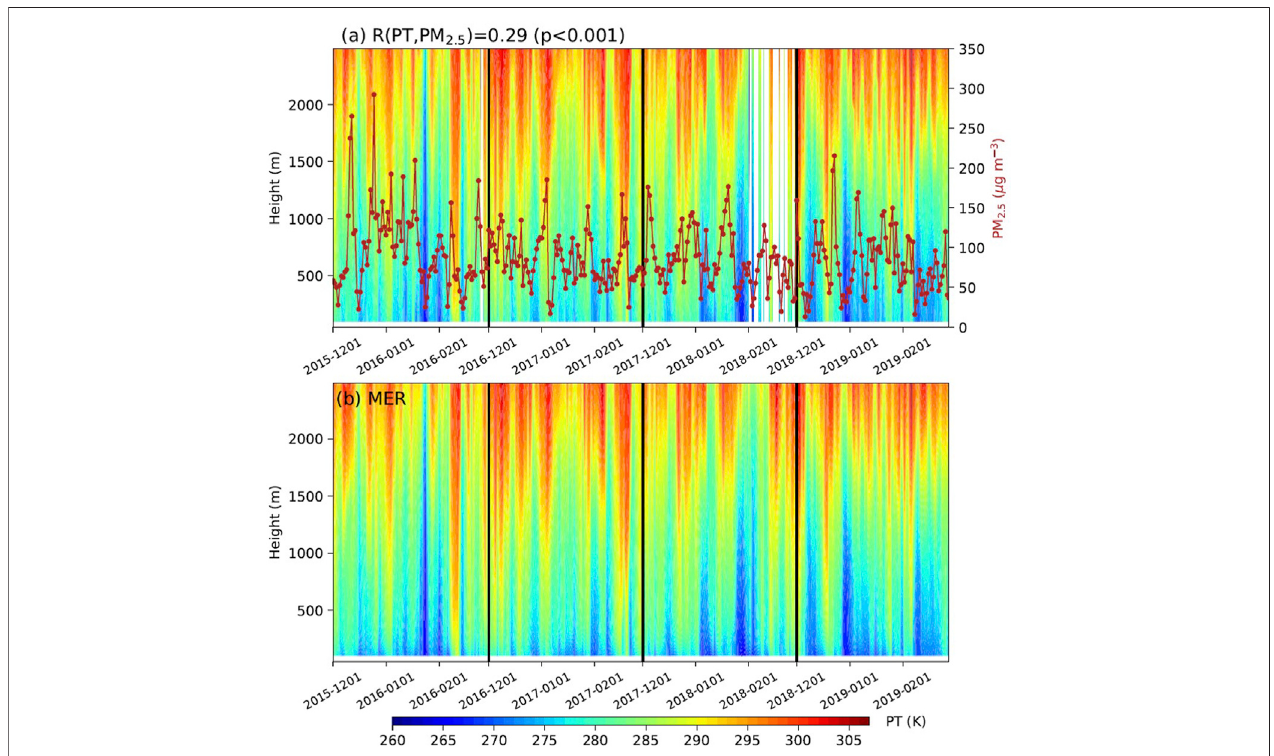
FIGURE 1 | Time-height sections of potential temperature (PT) in winter from December 2015 to February 2019 in Wuhan, derived from (A) radiosonde measurementsand (B) MERRA-2at08:00LT.In (A) ,thetimeseriesofdailyPM 2.5 concentration(redlineanddots)isalsoshown,andthecorrelationcoef fi cientbetween the daily concentration and 850-hPa PT is 0.29 ( p < 0.001). The correlation coef fi cient between the measured PT pro fi les and MERRA-2 PT pro fi les is 0.99 ( p < 0.001).